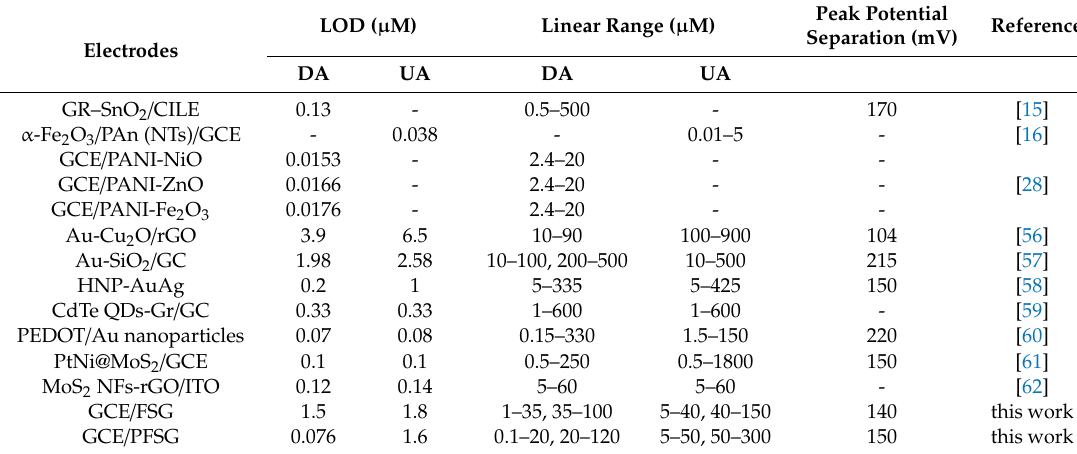
Table 3. Electrochemical performance of the GCE / FSG and GCE / PFSG electrodes in the detection of DA and